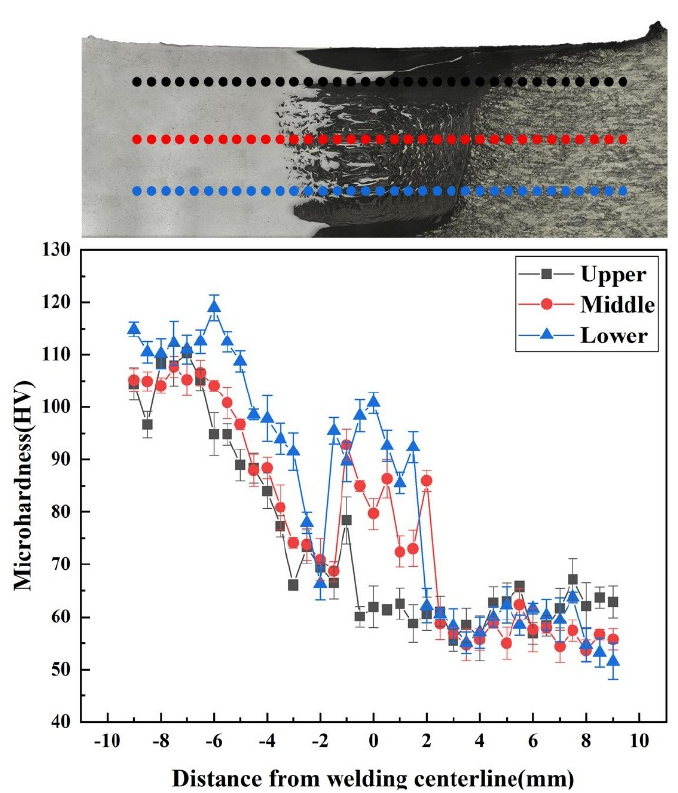
Figure 12. Microhardness distribution profile of the SFSW dissimilar joint.